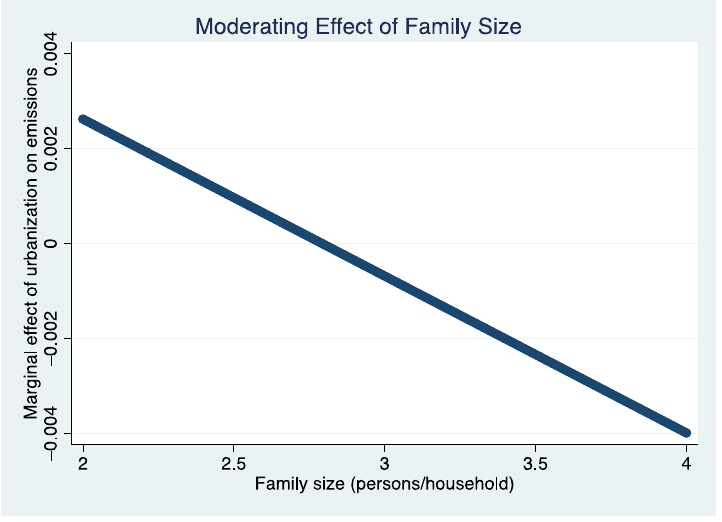
Figure 9. Moderating effect of family size. Table 5. Moderating effects of social factors on the relationship between urbanization and carbon dioxide emissions.